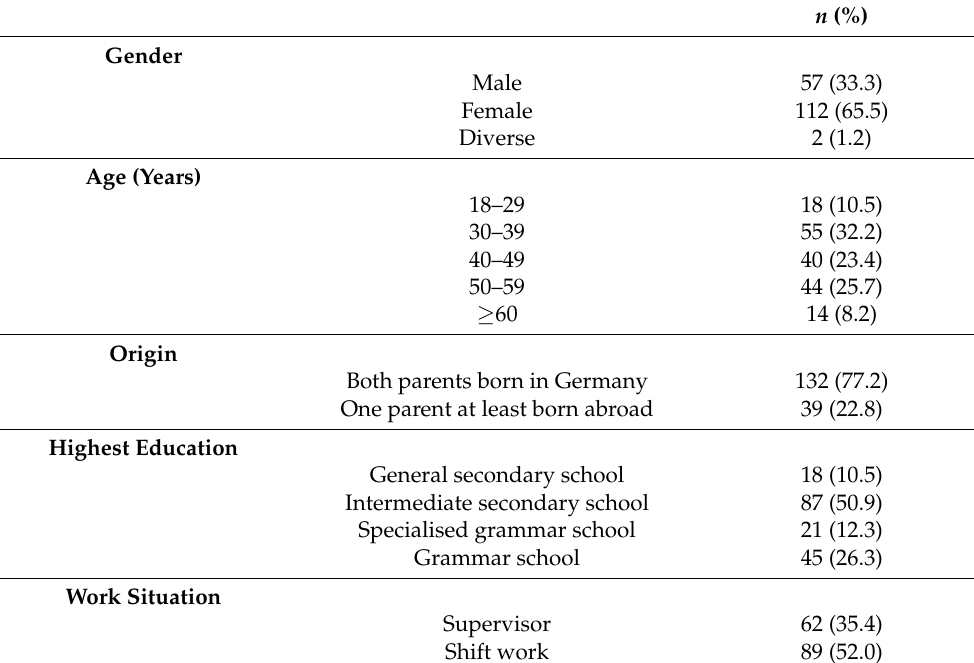
Table 1. Demographic